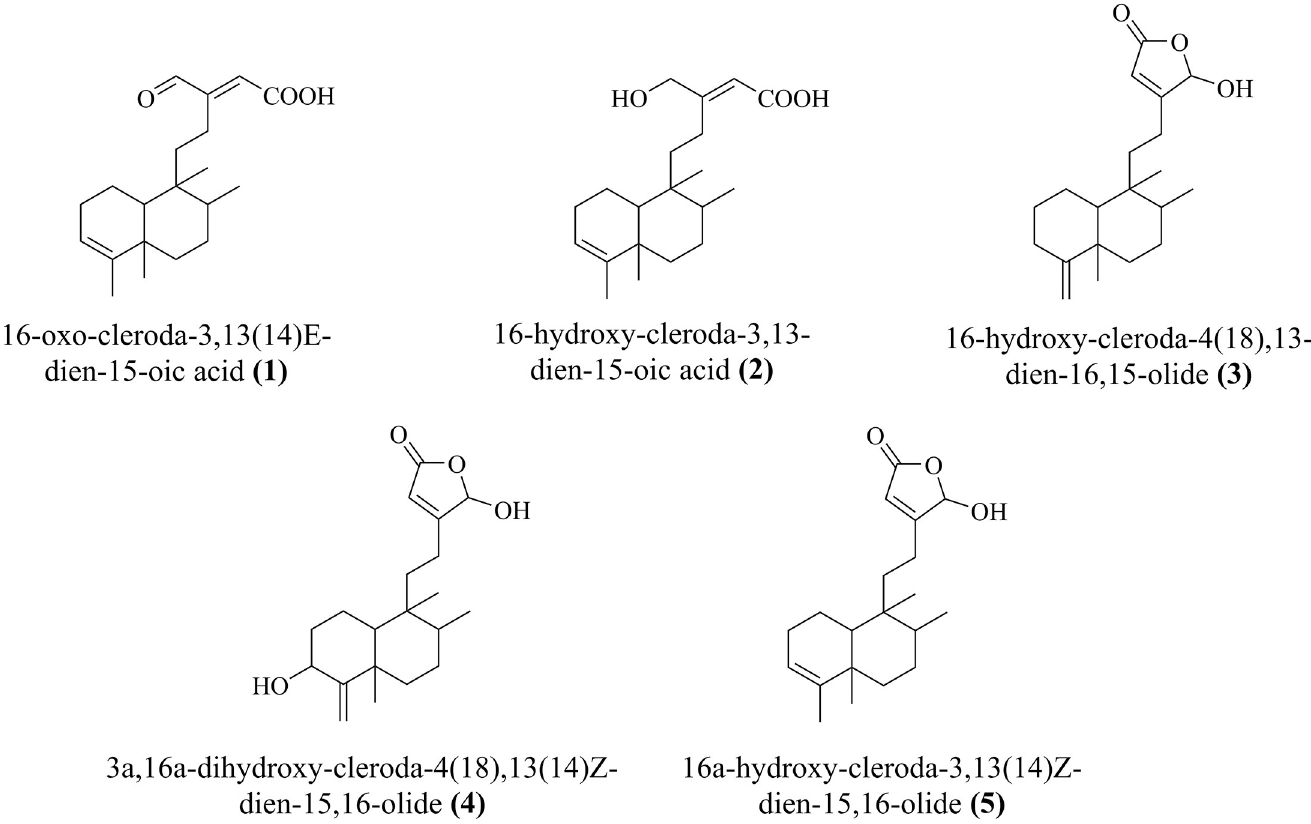
Fig 1. Chemical representation of clerodane diterpenes